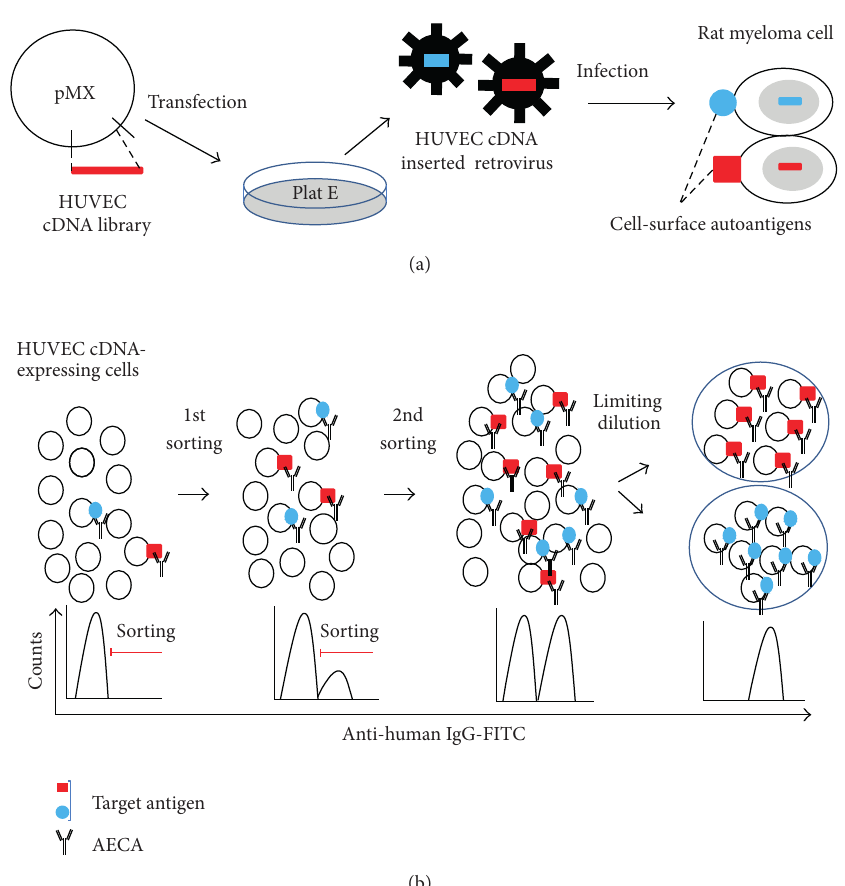
F 1: Serological identi�cation system for autoantigens using a retroviral vector and �ow cytometry (SARF). (a) Generation of human umbilical vein endothelial cell (HUVEC) cDNA-expressing cells. (b) Sorting of cells expressing cell-surface autoantigens.